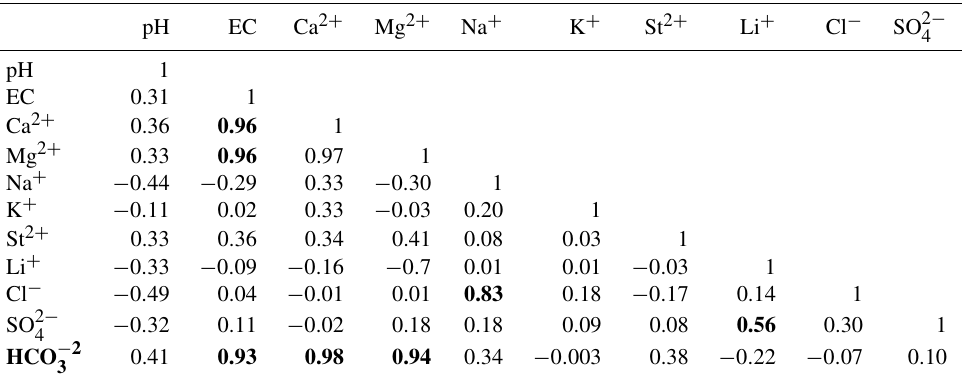
Figure 8. Cluster localisation obtained with the k -means method. Table 3. Correlation matrix. The bold values show the correlation greater than